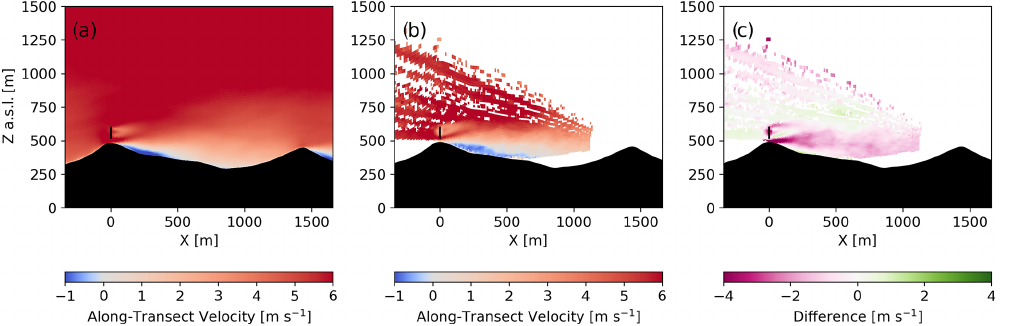
Figure 9. Transect of 1h time-averaged along-transect velocity for the model (a) and DLR lidar (b) during the convective case study with panel (c) as the difference between the DLR lidar and the model. The transects are aligned with the wake transect in Fig.